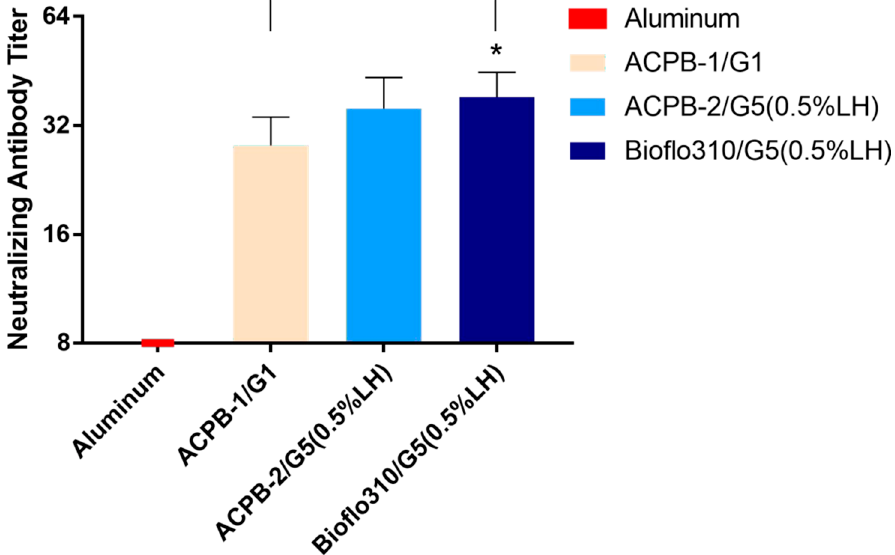
Figure 5. Neutralizing antibodies produced by mice immunized using the inactivated CVA16 vaccine. Titers of neutralizing antibodies (GMTs and 95% CI) in serum samples collected from mice immunized with the inactivated CVA16 vaccine or aluminum as a control ( n = 8) at 14 days after the first immunization. The neutralization test was based on the highest dilution of the serum that stopped cells from undergoing a cytopathic effect. Data are presented as means, n = 8, * p < 0.05 compared with the ACPB-1/G1. CVA16, Coxsackie virus A16; GMT, geometric mean titer; CI; confidence interval.